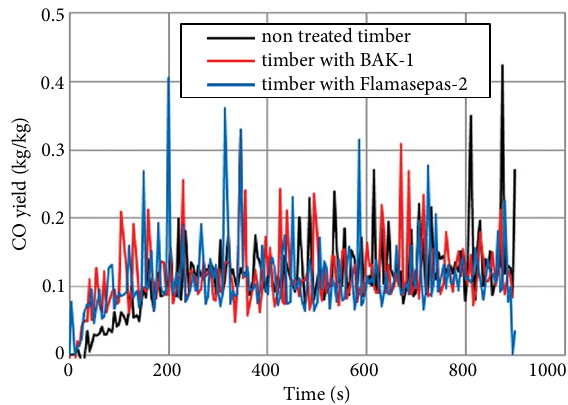
Fig. 11. A peak of CO yield obtained during the combustion of non-treated and treated specimens in the cone calorimeter at the heat flux of 30 kW/m 2 (without piloted ignition)